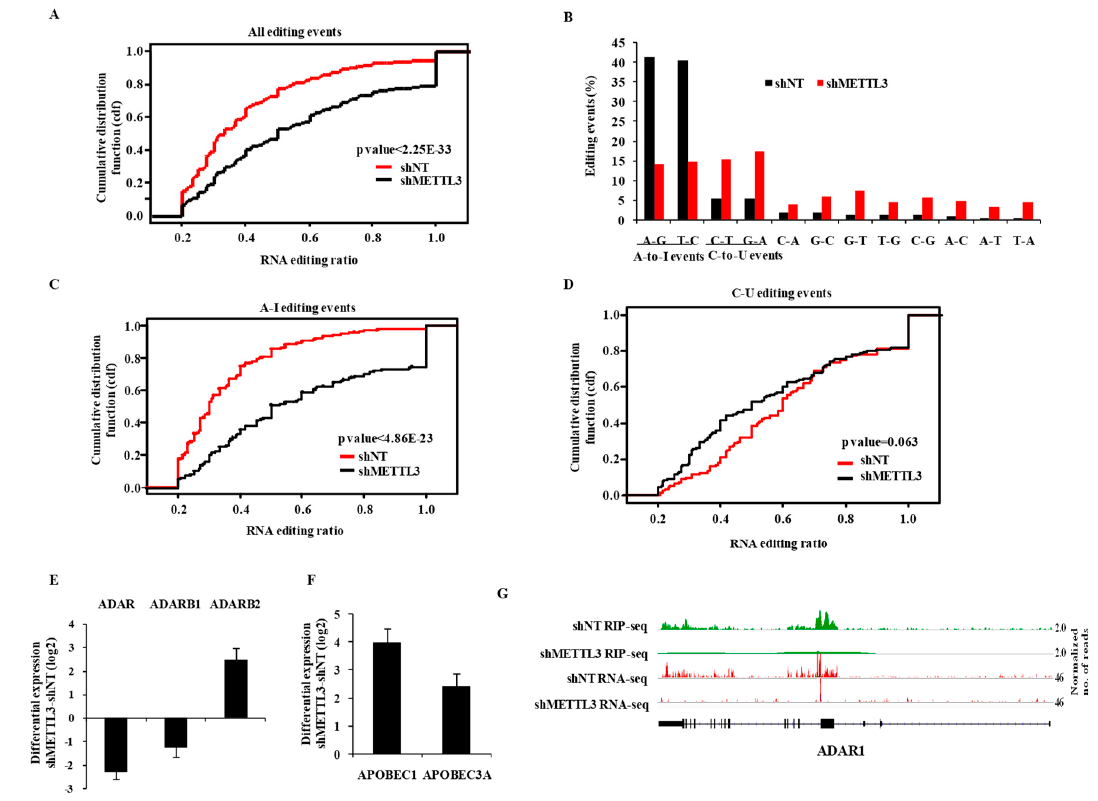
Figure 3. METTL3 regulates the RNA editing process. ( A ) A cumulative fraction plot of ratios for all RNA editing events in shNT vs. shMETTL3 conditions. METTL3-silencing reduced the events at varying editing ratios. ( B ) Percentage of different types of editing events between shNT and shMETTL3 cells presented as a bar diagram. A–G and C–G conversion (A-to-I editing) events decreased, while C–U and G–A conversion (C-to-U editing) events increased with METTL3-silencing. ( C , D ) Cumulative fraction plots of the ratio of A-to-I and C-to-U RNA editing events in shNT vs. shMETTL3 conditions are shown, respectively. METTL3-silencing reduced the A-to-I events at different editing ratios. ( E ) Differential log 2 expression (shMETTL3-shNT) of A-to-I editing enzymes ADAR, ADARB1 and ADARB2 presented as a bar diagram. ( F ) Differential log 2 expression (shMETTL3-shNT) of C-to-U editing enzymes APOBEC1 and APOBEC3Apresented as a bar diagram. ( G ) The genomic track of ADAR is depicted in shNT and shMETTL3-GSCs. Normalized sequence coverage of m 6 A RIP peaks and RNA-Seq reads is indicated above the gene architecture in UCSC format. Thin black boxes represent the 5 (cid:48) and 3 (cid:48) UTRs, thick black boxes represent the coding sequences, and thin lines represent introns. ADAR showed m 6 A RIP peaks in control GSCs, which was depleted in shMETTL3